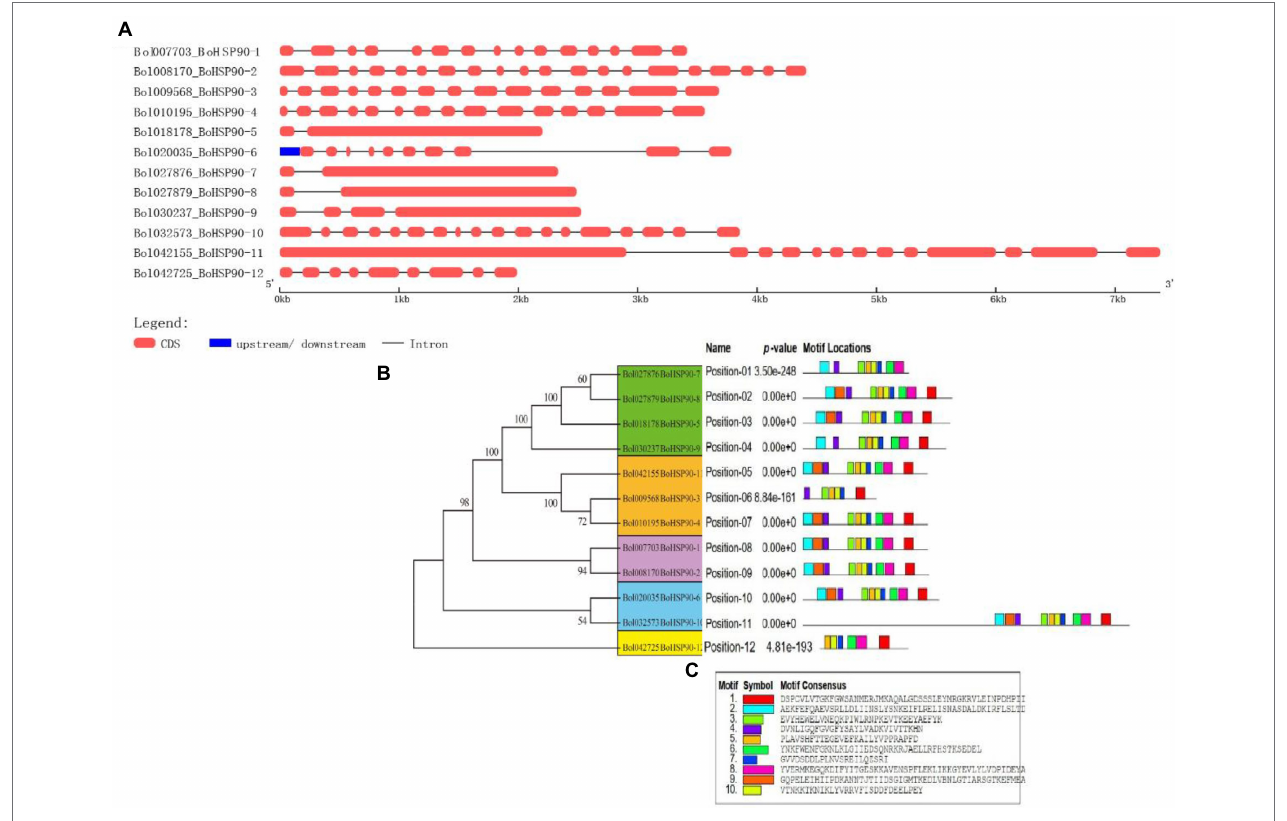
FIGURE 2 | Gene structure and conserved motif analysis of BoHsp90 genes. (A) Gene structure of the BoHsp90 genes in cabbage. (B) Motif composition of BoHsp90 . (C) A conserved motif in BoHsp90 gene was detected with MEME. Ten different motifs are represented by variously colored